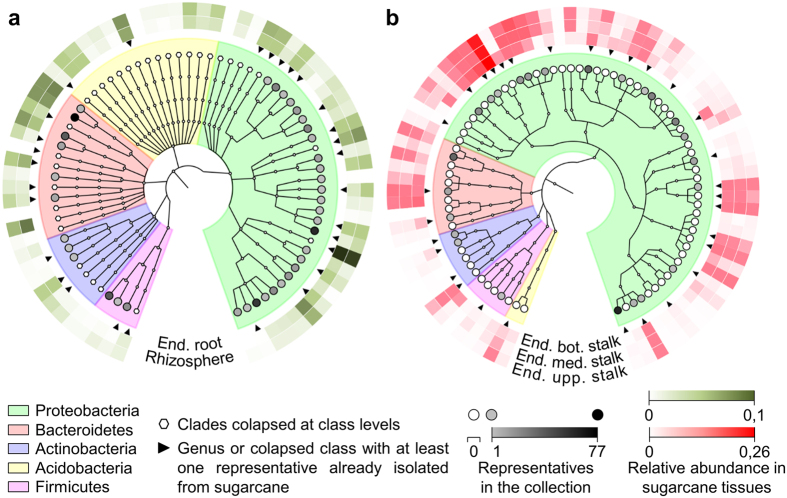
Cross-referencing of community-based culture collection (culture-dependent) and sugarcane microbial profile (culture-independent).The sugarcane community profile has identified a core bacterial community comprised of less than 20% of the total microbial richness but accounting for over 90% of the total microbial relative abundance23 (Supplementary Note). Because of its relevance, we have highlighted the recovery for the core microbiome. OTUs in five culture collection plates were cross-referenced against core community profile from root (rhizosphere and endophytic root) and stalks (endophytic bottom, medium and superior region of stalks) from sugarcane plants. The identified isolates comprised OTUs that account for 14.2% and 29.1% of the total bacterial relative abundance in sugarcane roots and endophytic stalk, respectively. Cladograms were constructed at the genus level based on taxonomy assignment. (a) Endophytic root and rhizosphere microbiota. The cladogram was simplified to show only five phyla; genera with no representatives in the collection were collapsed (see Supplementary Fig. 8 for detailed information). (b) Endophytic stalk microbiota. End.: endophytic. Bot.: bottom. Med.: medium. Upp.: upper.